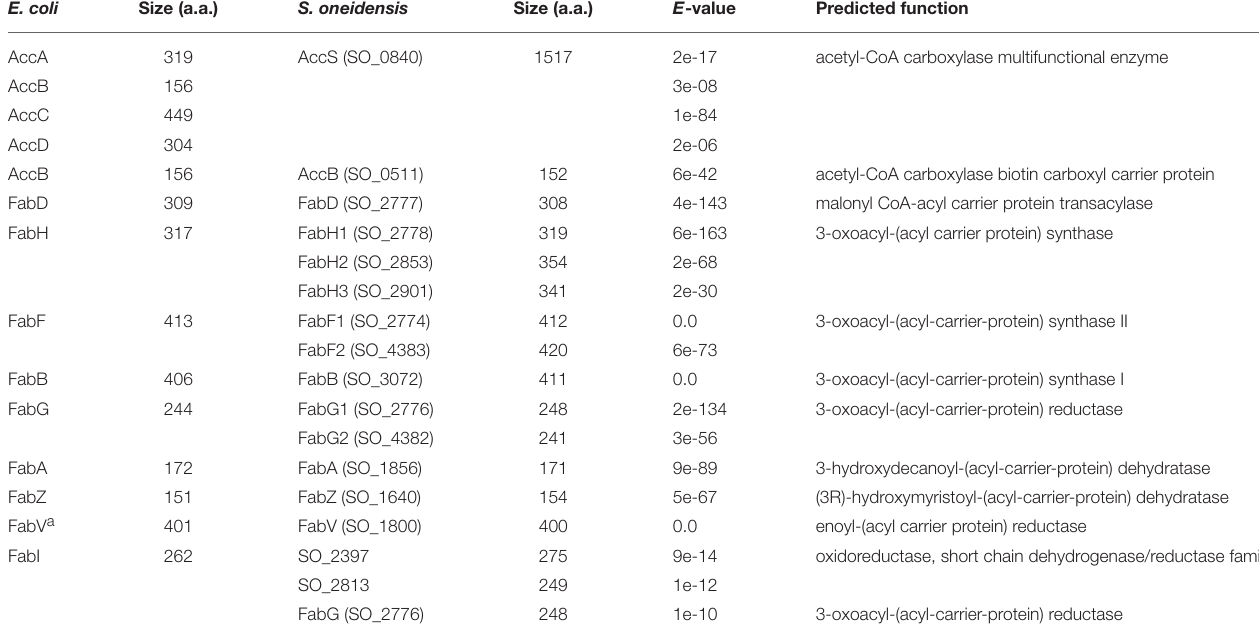
TABLE 2 | S. oneidensis homologs of Escherichia coli FAS II components. E.